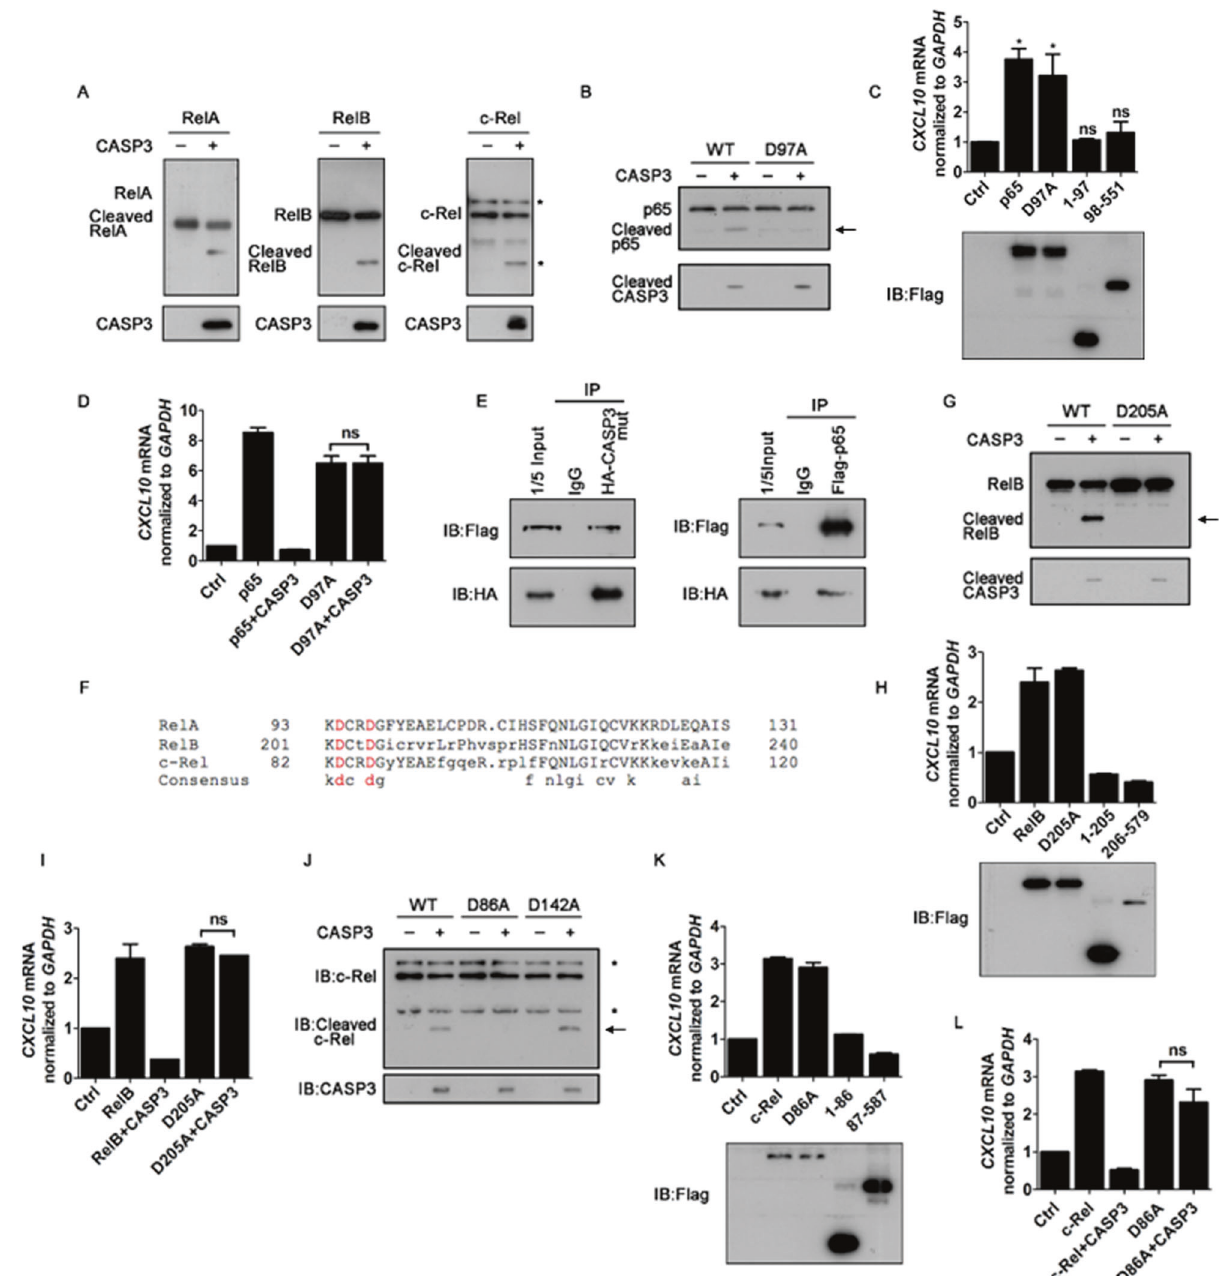
Fig. 4 Caspase-3 cleaves RelA at D97, RelB at D205 and c-Rel at D86. A Immunoblot of puri fi ed N-terminal GST and C-terminal Flag tagged proteins as indicated incubated without ( − ) or with caspase-3 ( + ) for 60 min at 37 °C. The blot was probed with anti-Flag antibody. B Immunoblot of puri fi ed WT and D97A mutant of RelA proteins incubated without ( − ) or with caspase-3 ( + ) for 60 min at 37 °C. The blot was probed with anti-Flag antibody. C Quantitative RT-PCR analysis of CXCL10 mRNA in HEK293T cells transfected with RelA and its mutants or truncations followed by immunoblot analysis. D Quantitative RT-PCR analysis of CXCL10 mRNA in HEK293T cells transfected with RelA (p65), its mutant and caspase-3 as indicated. E 293T cells were transfected with Flag-p65 and HA-tagged protease-defective mutant CASP3. Co- immunoprecipitations were performed by using anti-HA or anti-Flag antibody, followed by immunoblot analysis with indicated antibodies. F Alignment of the amino acid sequence of RelA, RelB and c-Rel, the putative caspase-3 recognition motif DXXD was highlighted (red). G Immunoblot of puri fi ed WT and D205A mutant of RelB proteins incubated without ( − ) or with caspase-3 ( + ). The blot was probed with anti- Flag antibody. H , I Quantitative RT-PCR analysis of CXCL10 mRNA in HEK293T cells transfected with RelB, its mutants or truncations ( H ) and caspase-3 ( I ) as indicated. J Immunoblot of puri fi ed WT, D86A and D205A mutant of c-Rel proteins incubated without ( − ) or with caspase-3 ( + ). The blot was probed with anti-Flag antibody. K , L Quantitative RT-PCR analysis of CXCL10 mRNA in HEK293T cells transfected with c-Rel, its mutants or truncations ( K ) and caspase-3 ( L ) as indicated. Data are representative of three independent experiments (means with SEMs). * p < 0.05, ** p < 0.01, and *** p < 0.001.